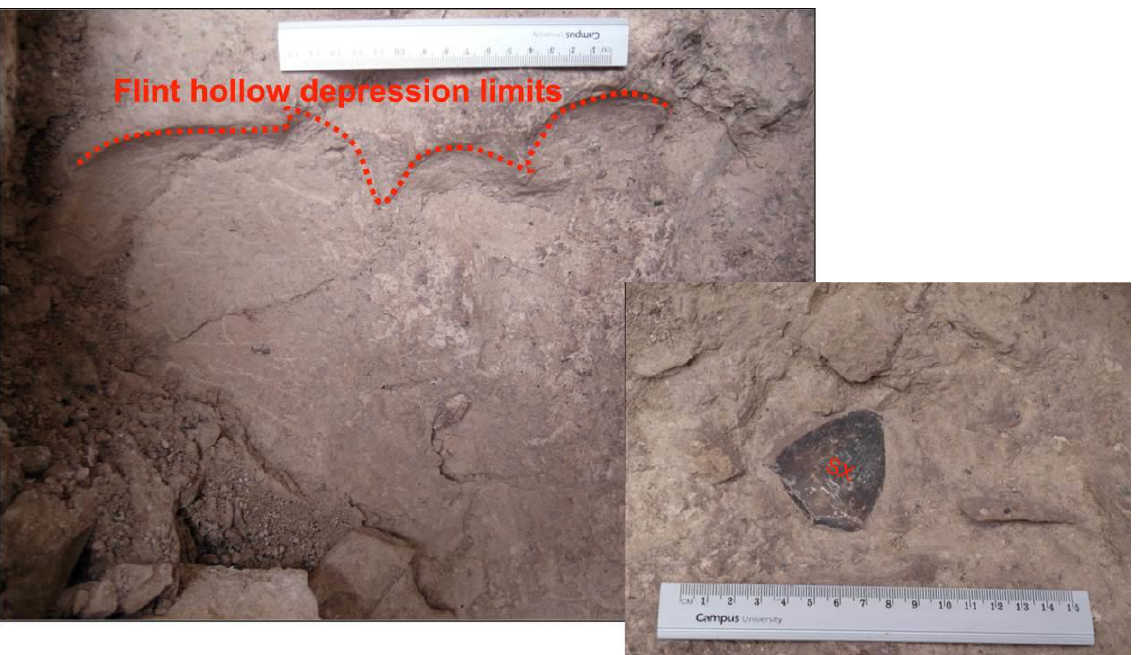
Figure 13. Left: Hollow depressions of the flint nodules after their extraction from the bedrock. Right: A piece of nodular flint still within the host rock.